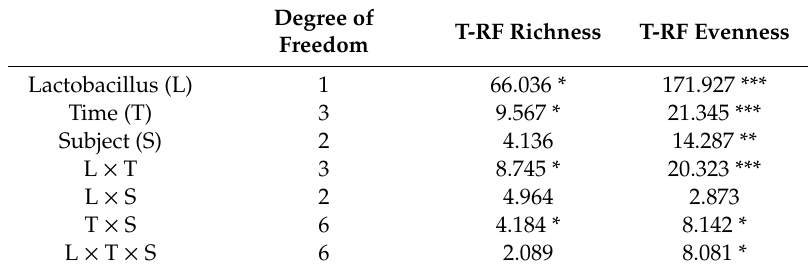
Table 1. Summary of the Three-Way Repeated Measures ANOVA (F values), assessing the e ff ects of